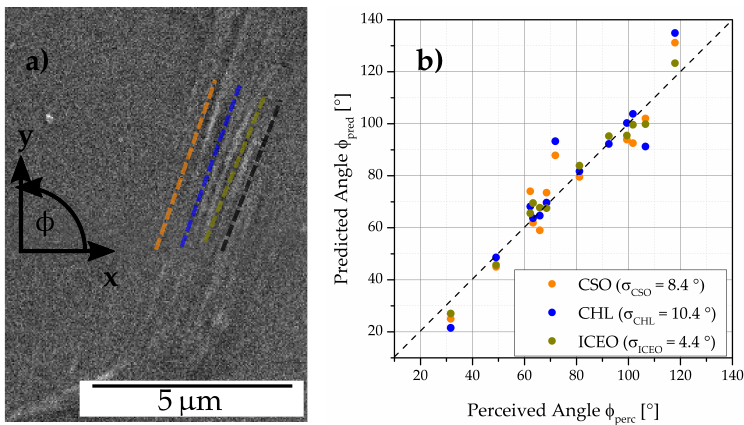
Figure 8. In ( a ) the expert perceived orientation φ perc (black) as well as different predicted slip trace orientations φ pred derived using clustering of Scharr gradient based edge orientations (orange), clustering Hough lines from edges (blue) and iterative clustering of edge orientations (green) are illustrated for an example extrusion. The correlation of these φ pred with φ perc for a set of extrusions is shown in ( b ). Further, the standard deviation of the error ( σ x ) for each method is given.